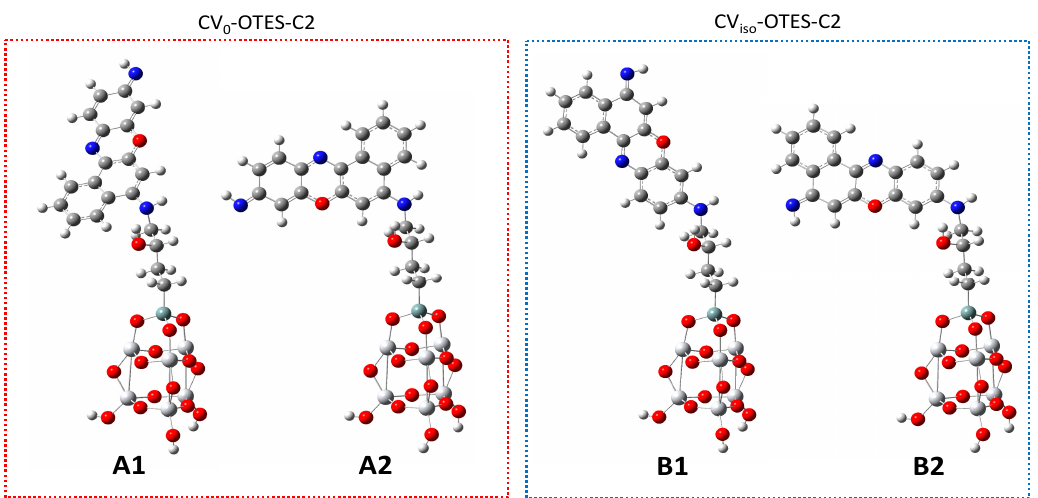
Figure 7. Optimized structures of CV–OTES–C2 adsorbed on the TiO 2 cluster in the gas phase, calculated using the B3LYP / 6-31G* / LanL2DZ level of theory. The conformations of CV 0 –OTES–C2 and CV iso –OTES–C2 are labeled as A1 and A2 and B1 and B2, respectively.